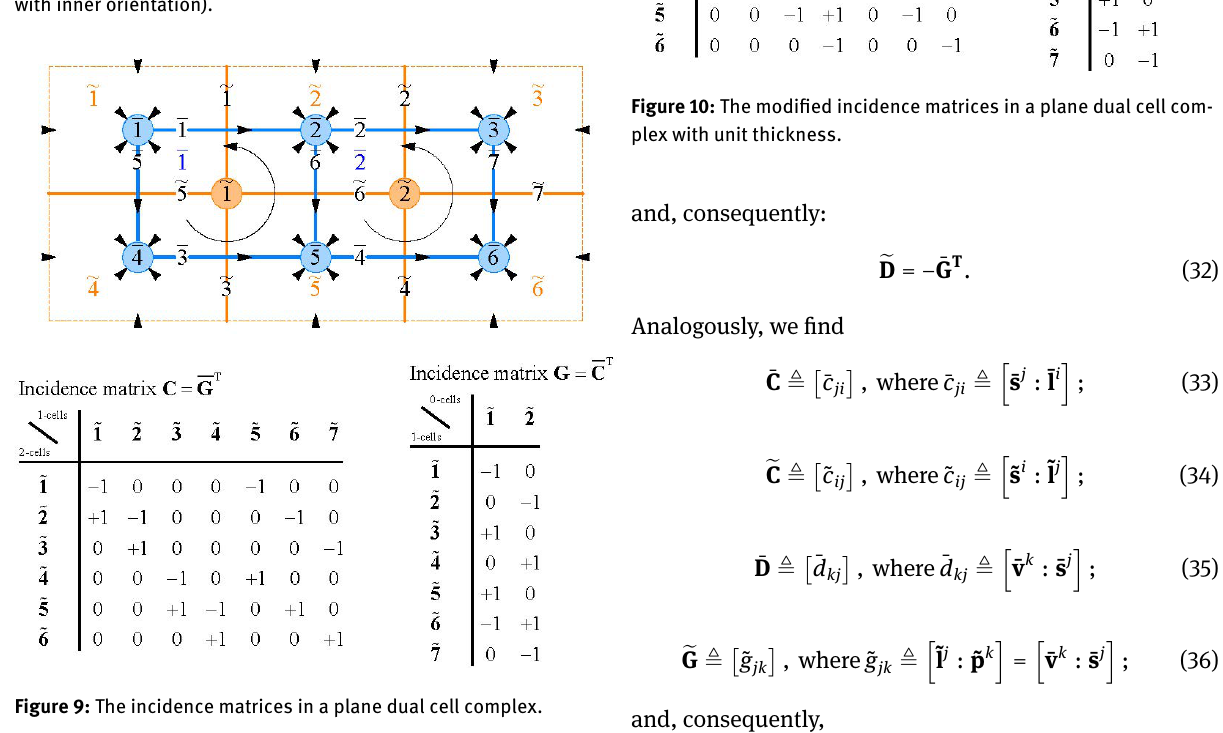
Figure 9: The incidence matrices in a plane dual cell complex.